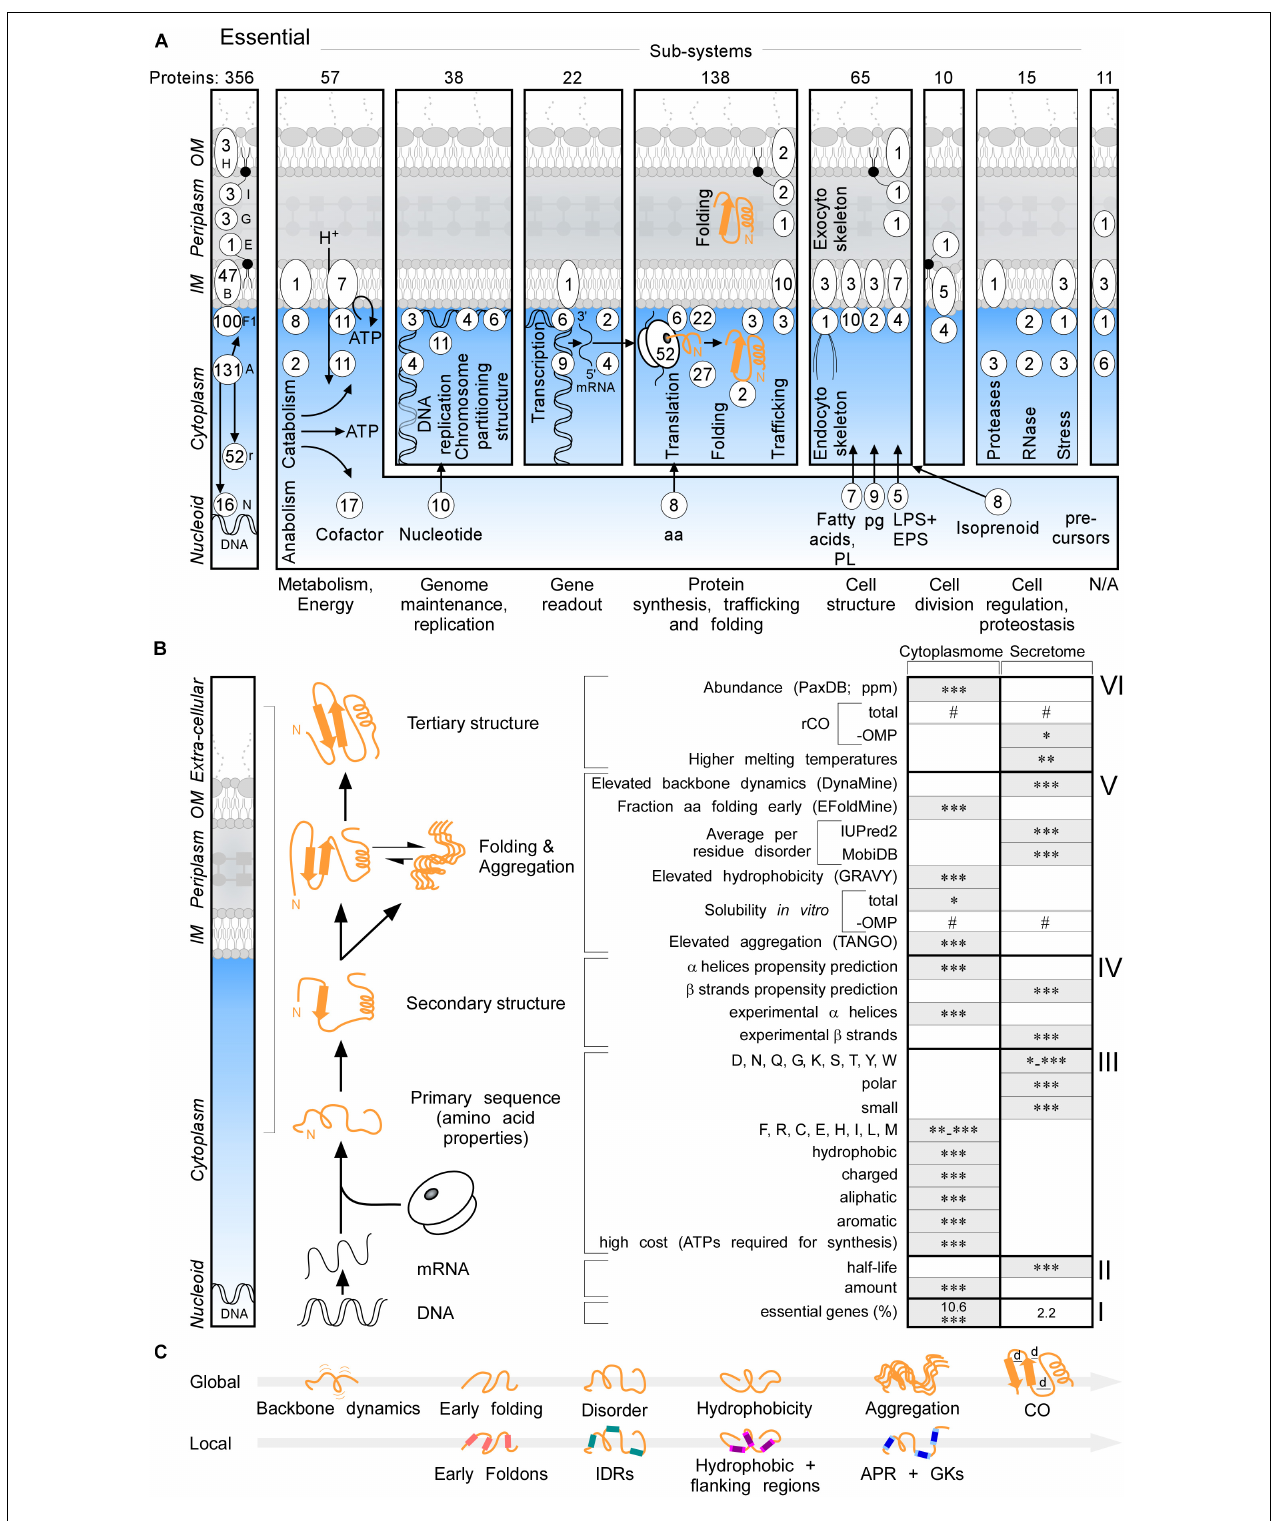
FIGURE 2 | Essential proteins and global features of the K-12 proteome. (A) Three hundred and fifty-six essential proteins (Goodall et al., 2018) of different functional sub-systems (see bottom) distributed in different topology locations. #The sum of essential proteins in each panel. (B) Comparison of the indicated global intrinsic features of cytoplasmic versus secreted proteins. Schematic representation a cell locations (left) and different steps of protein synthesis and folding (middle).